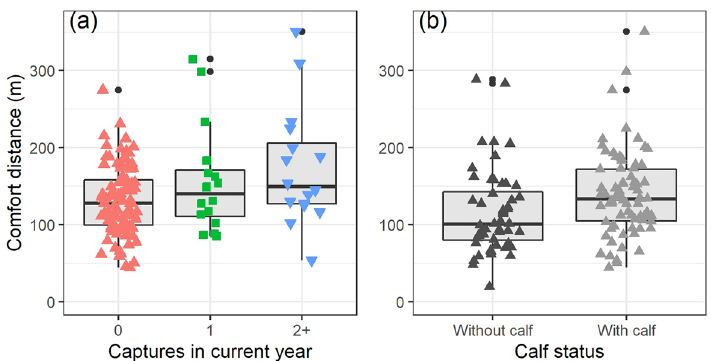
Figure 7. Comfort distances in female Svalbard reindeer in summer after having fled from humans approaching on foot. ( a ) Distances in individuals not captured (red triangles), captured once (green squares), or repeatedly (2–4 times; blue downward triangles) in the current year, corrected for start distance and calf status. ( b ) Distances in females with or without a calf at heel, corrected for start distance and capture frequency (predicted for zero captures). In both panels, boxes show median (solid line), the 25th and 75th percentiles (lower and upper hinges), with whiskers corresponding to max. 1.5 times the inter-quartile range. Outliers are shown as solid circles.